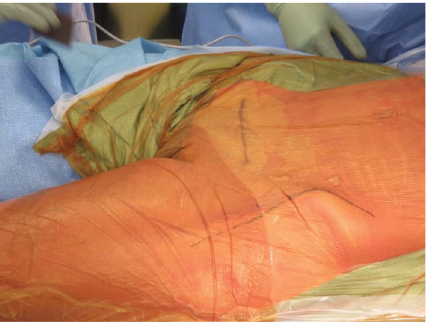
Figure 3: Intraoperative picture showing the planning of the incisions for the dual approach: Pfannenstiel and Smith-Petersen,